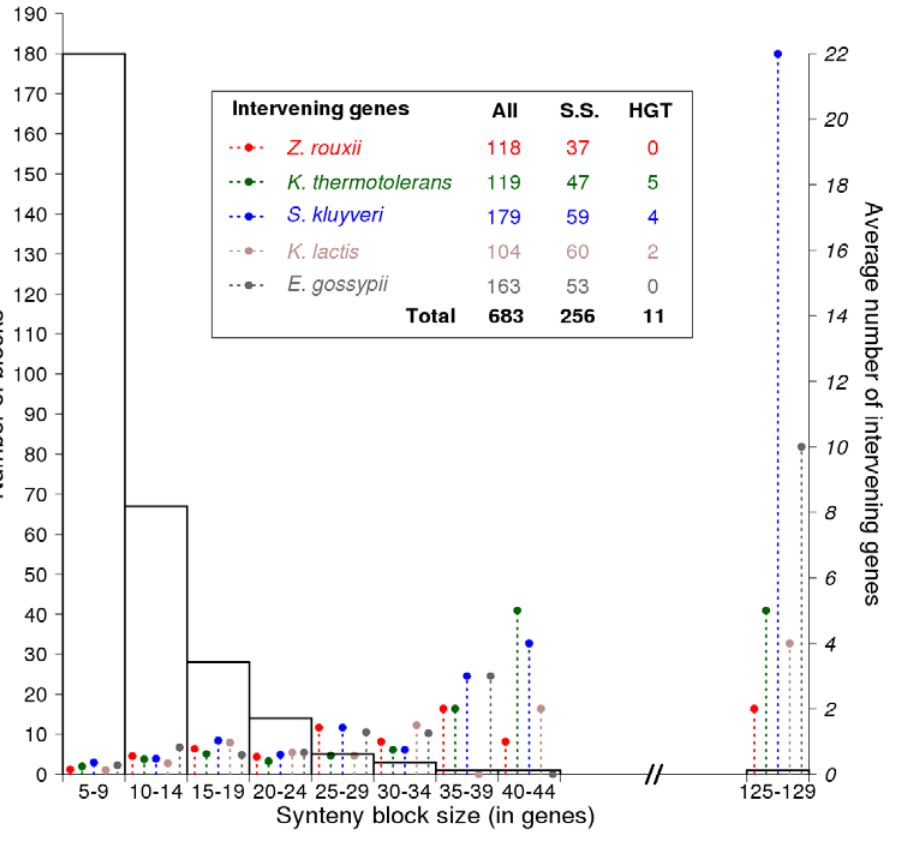
Figure 2. Size distribution of conserved synteny blocks among the five protoploid Saccharomycetaceae , and intervening gene numbers. Synteny block common to all 5 protoploid Saccharomycetaceae species (inset) were classified by their number of anchoring points (abscissa, Materials and Methods). The number of blocks in each size category is referred to the scale on the left axis. The mean number of intervening genes per species and per block category is represented by dotted lines (scale on the right axis), and total figure for each species are in inset. All: total number of intervening genes. S-S: total number of species-specific intervening genes. HGT: total number of horizontally transferred genes.